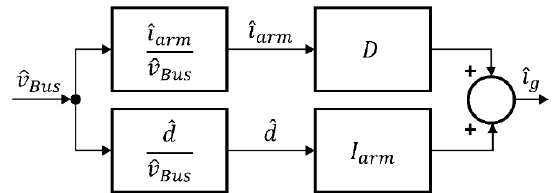
Figure 20. Modified block diagram of the motor drive-electric motor-vehicle system with the inner control loop.